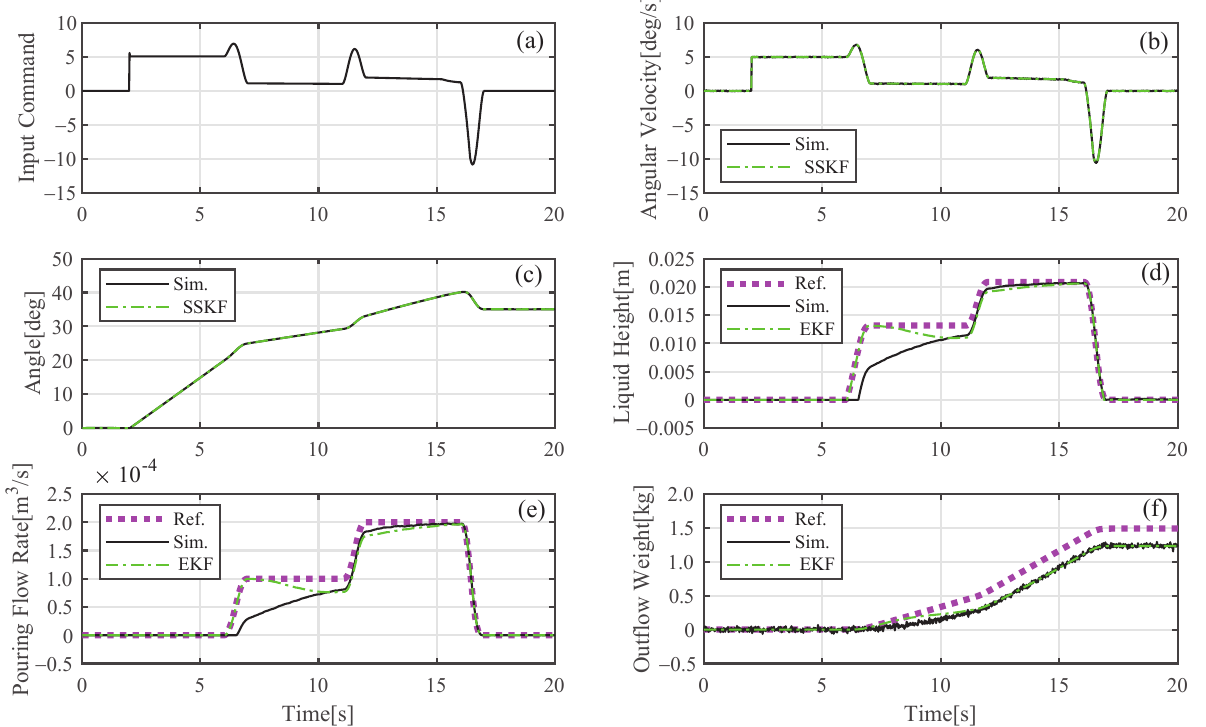
increased alongside an increase in the error between the ideal and actual liquid volumes.